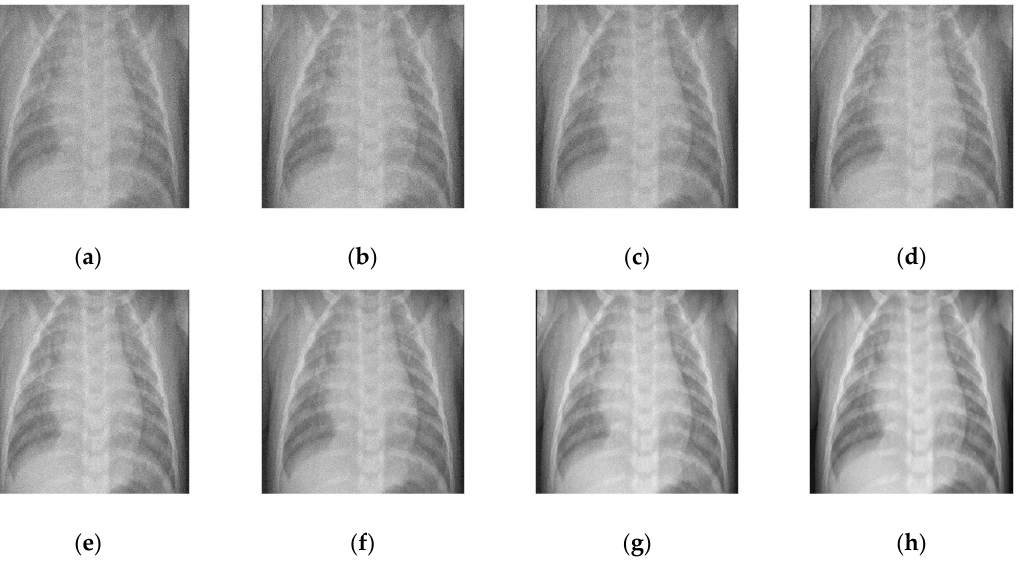
Figure 7. Denoised COVID-19 CT image 4 for the ( a ) [10], ( b ) [11], ( c ) [12], ( d ) [13], ( e ) [14], ( f ) [11], ( g ) [16], and ( h ) proposed frameworks, respectively.